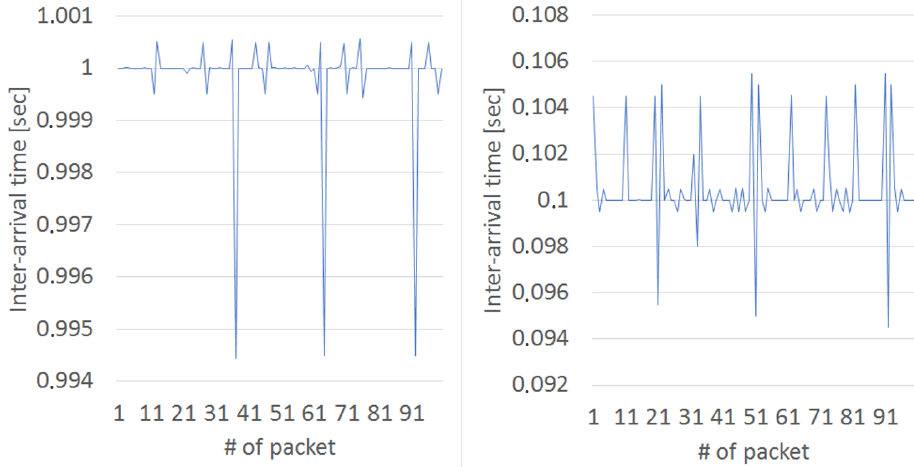
Figure 23. Jitter results ( left ): 1000 Byte packets, 1000 ms sending period, ( right ): 1000 Byte packets, 100 ms sending period with 50% background